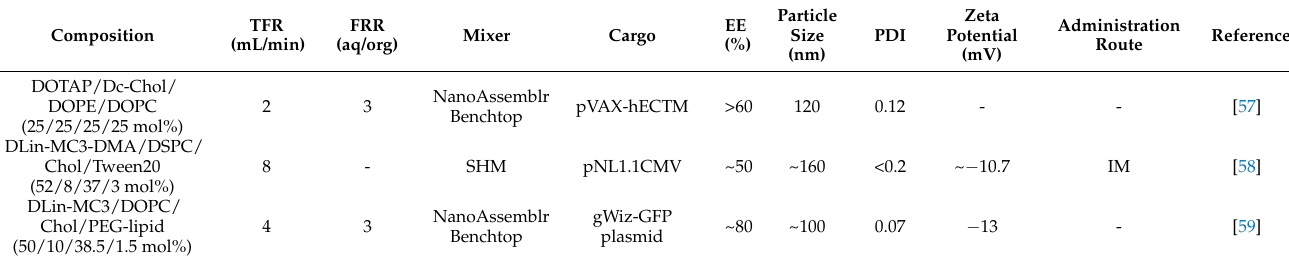
Table 4. pDNA LBNPs for drug delivery and their physicochemical